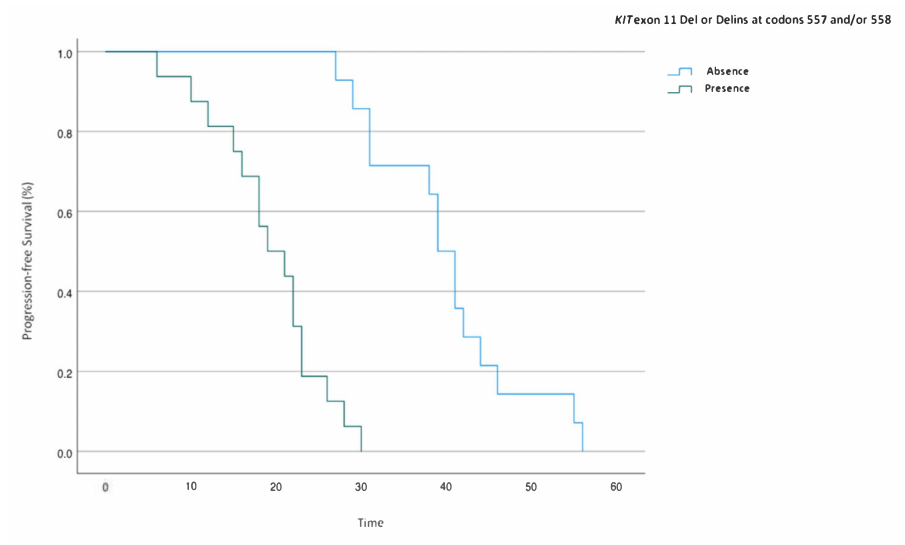
Figure 5. PFS analysis in mGIST patients harboring KIT exon 11 deletions or delins at codons 557 and/or